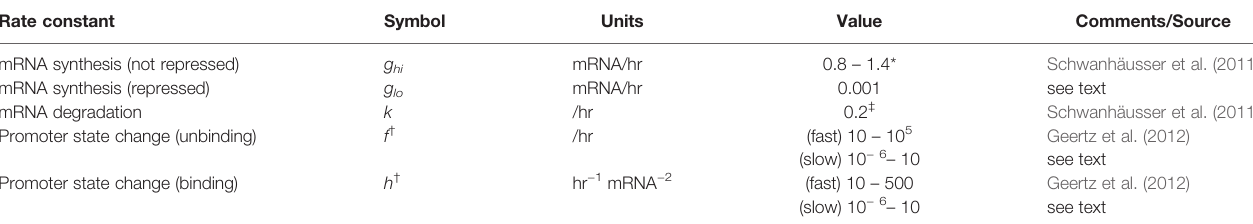
Parameter values are derived from experimental measurements in vertebrates, where possible. See Methods text for details. *Measured rates of mRNA synthesis varied, with a median of 2/h Schwanhäusser et al. (2011). We use lower values (within experimental range) to roughly match observed counts in scRNA-seq data, which may be lower than expected because of dropouts or other technical issues. ‡ Corresponds to mRNA half-life of 3.5 h, which is well within experimentally measured values but shorter than the median value of 9 h, assuming that transcriptional regulators have shorter-than-average half-lives in the cell. † Promoter state change rates f and k are reported in fast and slow regimes. Fast promoter state changes are assumed to occur due to TF-DNA unbinding or binding events, with rate parameters chosen based on values reported in Geertz et al. (2012) (see Supplement for details on parameter derivation and unit conversion). Slow promoter state changes are thought to involve collective changes in epigenetic marks and rearrangement of